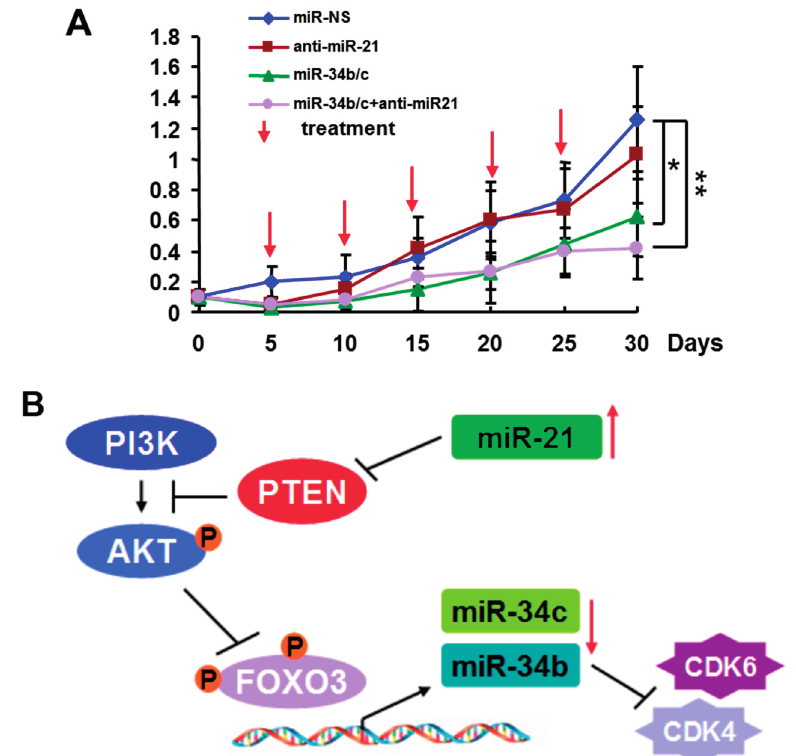
Figure 4. Systematic delivery of miR-34b/c or with anti-miR-21 inhibited breast tumor growth. ( A ) MDA-MB-231 cells were subcutaneously injected into immunodeficient